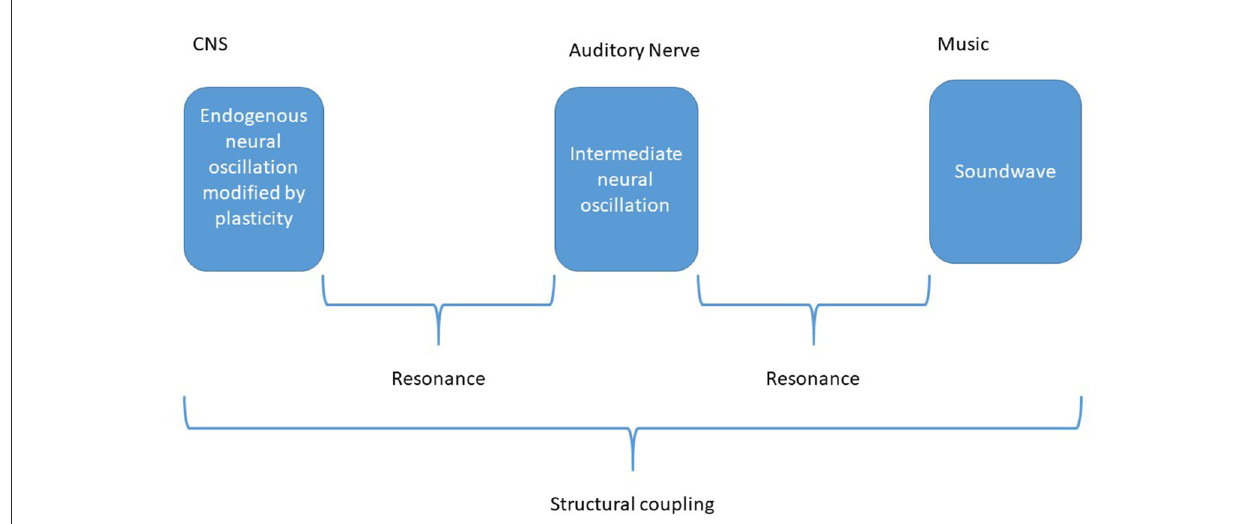
FIGURE1 Structural coupling in music perception. The listener is structurally coupled to music via two steps of resonance. The structure of the soundwave is converted to electrical potentials in the cochlea and picked up by the auditory nerve by way of neural resonance. The structure of endogenous